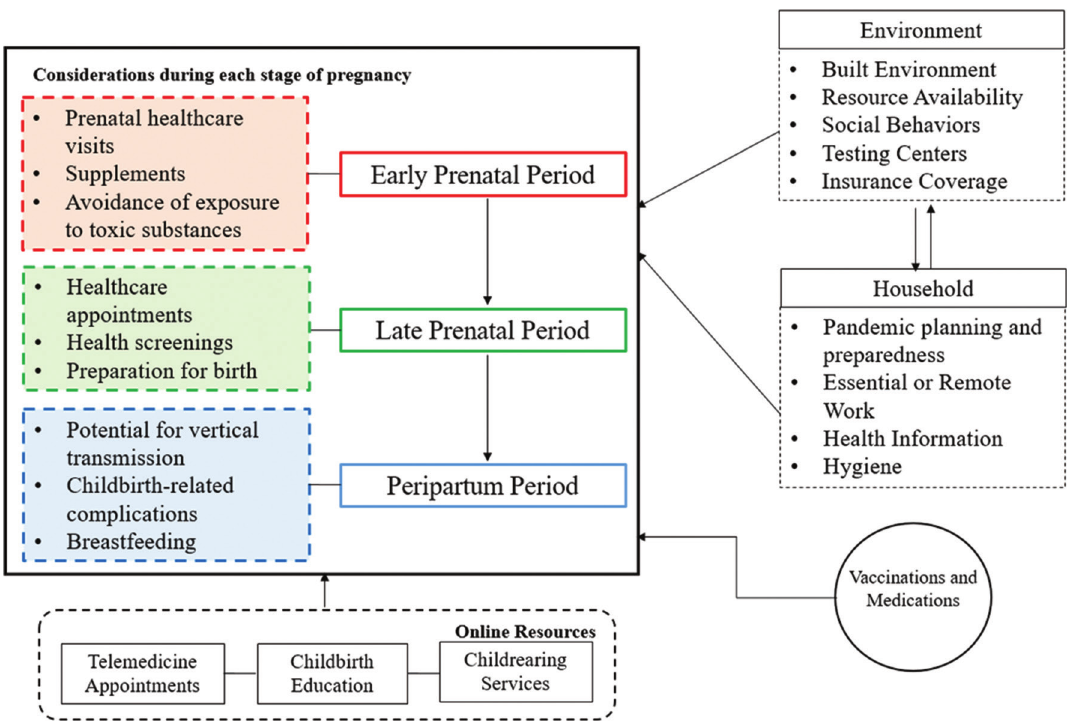
Figure 1. Framework for Protecting Pregnant Women During the COVID-19